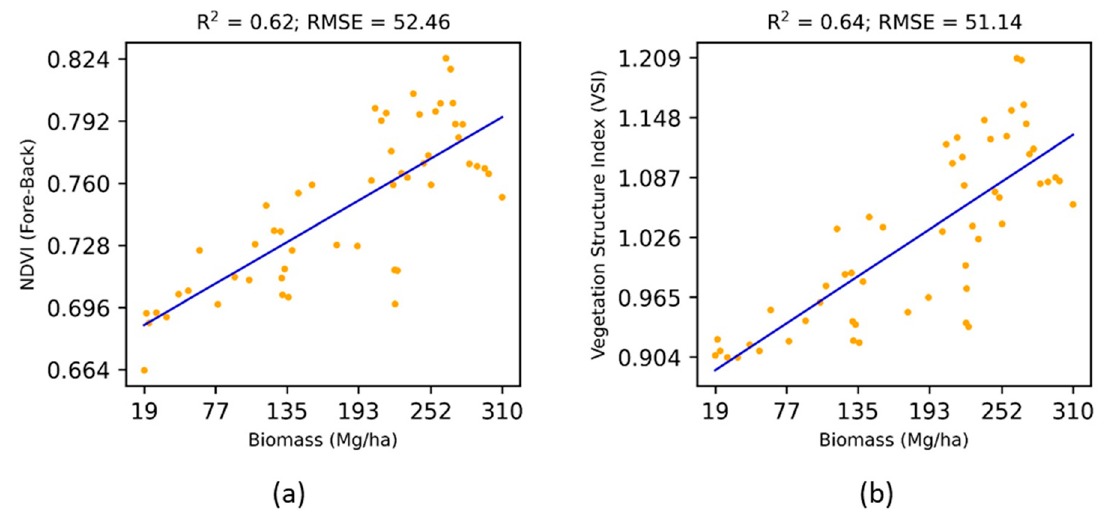
Figure 4. Performance of new multi-angular vegetation indices for the estimation of above-ground biomass.